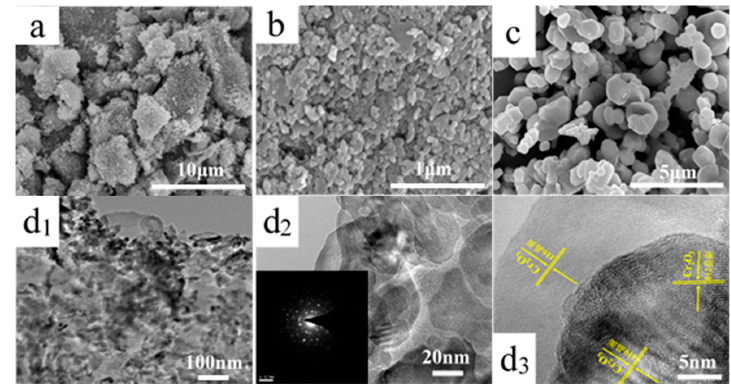
Figure 2. Morphology of Cr 2 O 3 catalyst prepared by different methods. SEM images of ( a ) Cr 2 O 3 -P, ( b ) Cr 2 O 3 -SCS and ( c ) Cr 2 O 3 -C; ( d 1 ), ( d 2 ) and ( d 3 ) TEM images of Cr 2 O 3 -SCS with different magnification and the inset in ( d 2 ) shows the corresponding SAED patterns.